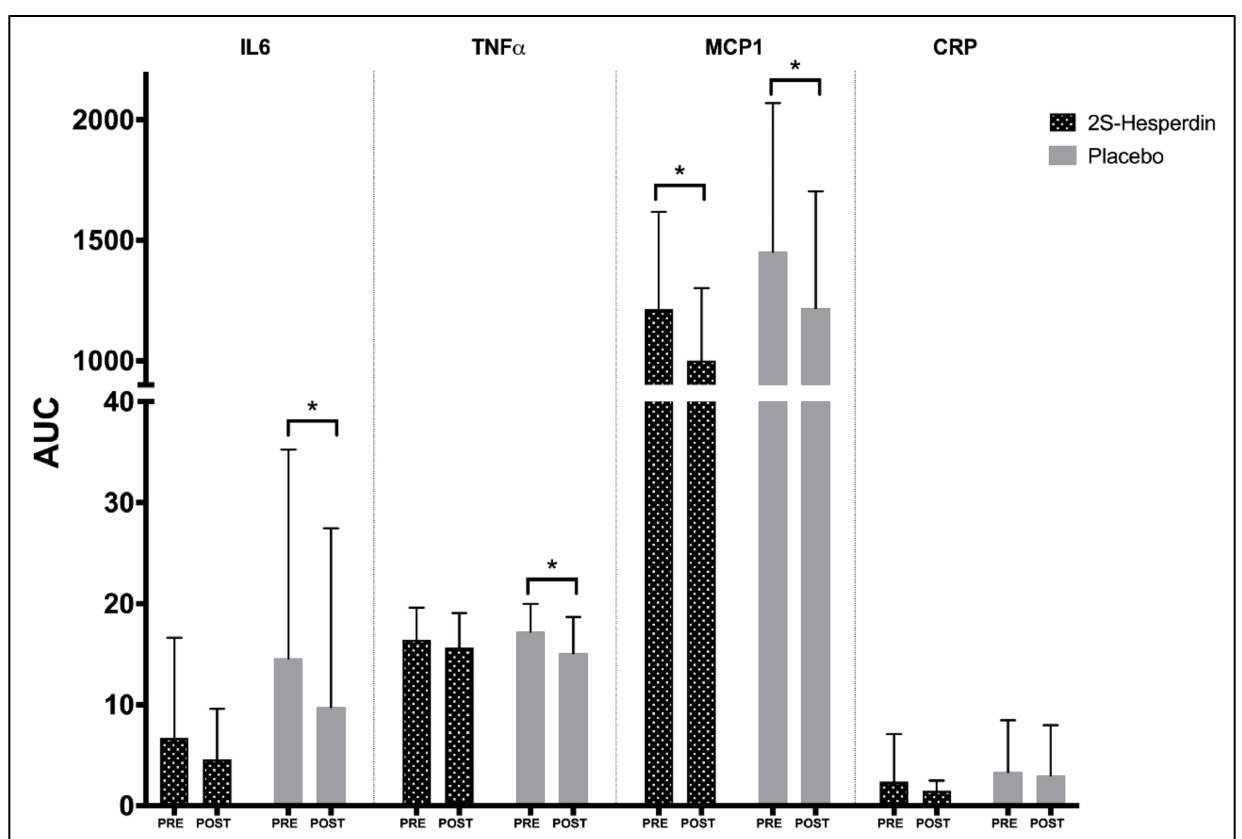
Figure 5. Intragroup differences between AUC (pre- and post-intervention) in inflammatory parameters. * p < 0.05. There were no significant differences between groups in